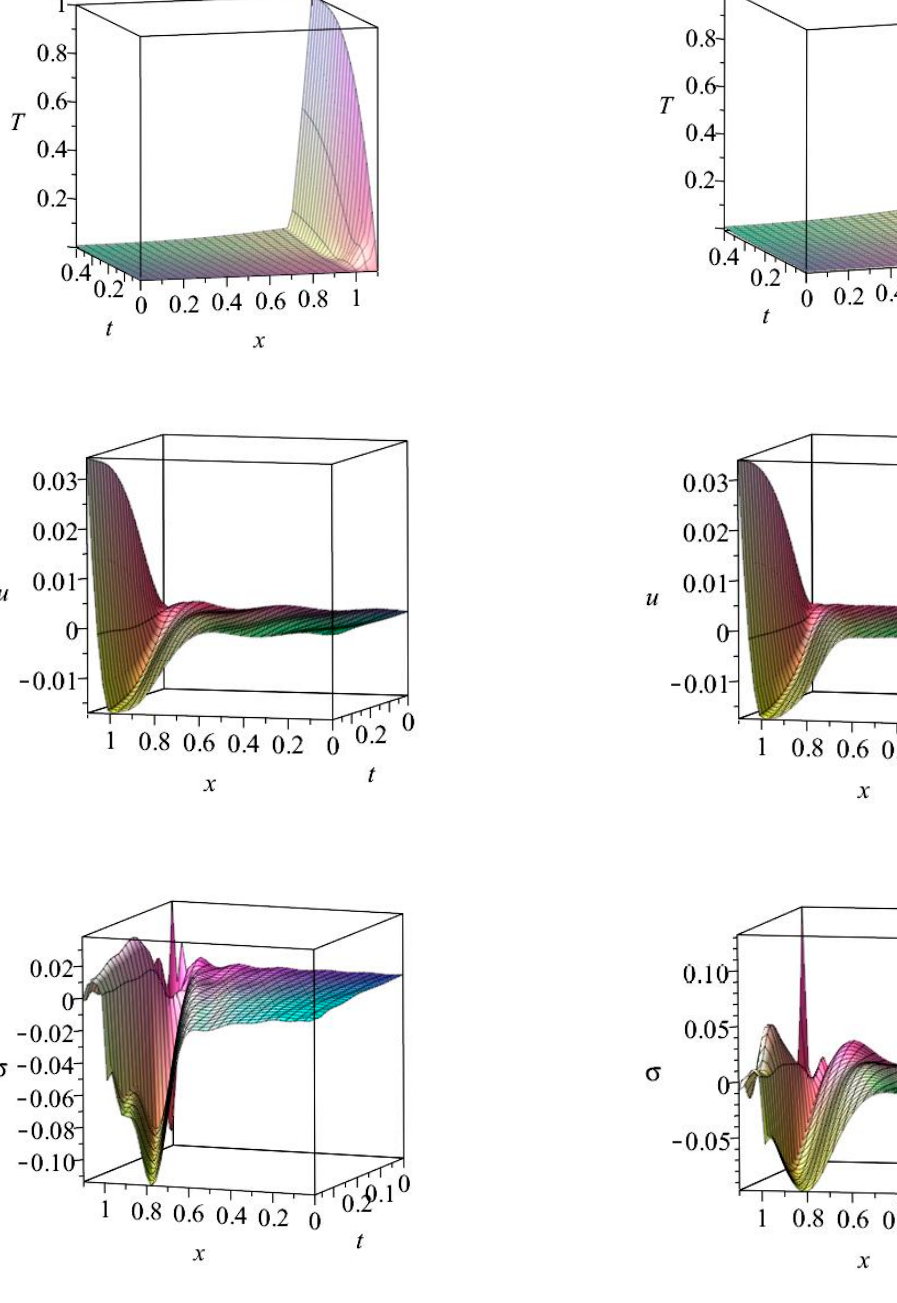
Figure 4. Temperature ( top row ), displacement ( middle row ), and stress ( bottom row ) field for two layers. On the left—approximation by a 10th degree polynomial, on the right—by a 24th degree polynomial.